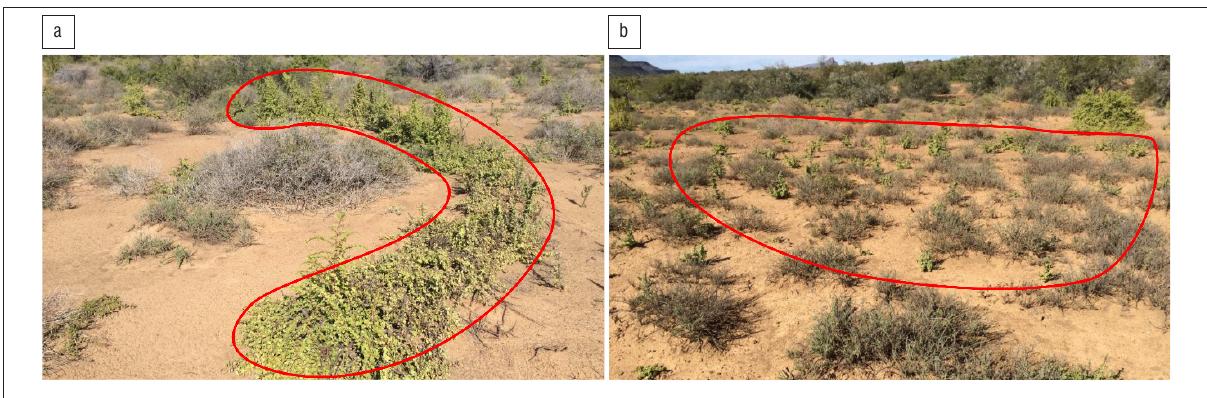
Figure 4: Comparison of spekboom growth after ~5 years after planting at Camdeboo National Park: (a) in dense clusters in a trench and (b) as single